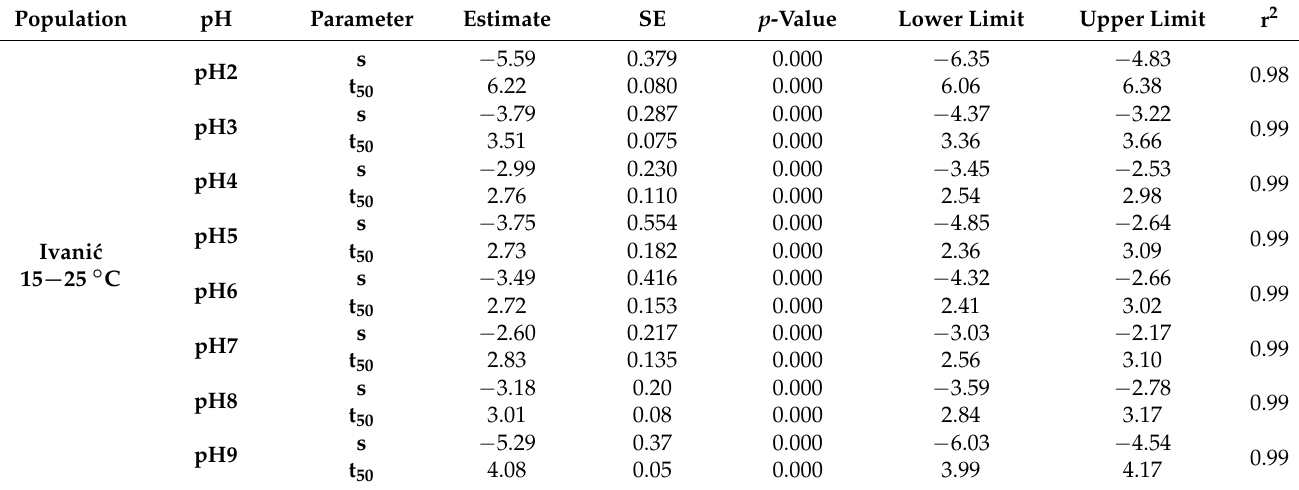
Table A2. Parameters of the log-logistic function for each population, temperature regime, and pH.